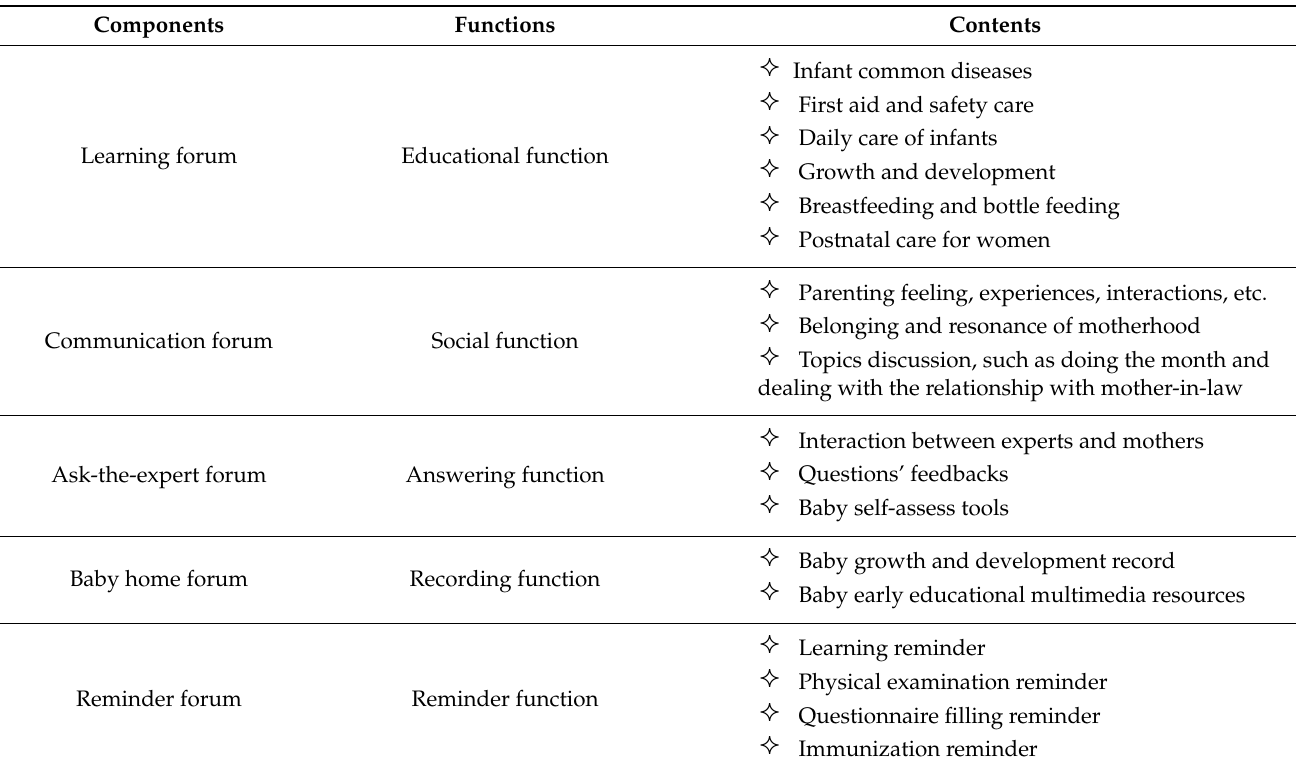
Table 1. Contents and functions of the ISP.